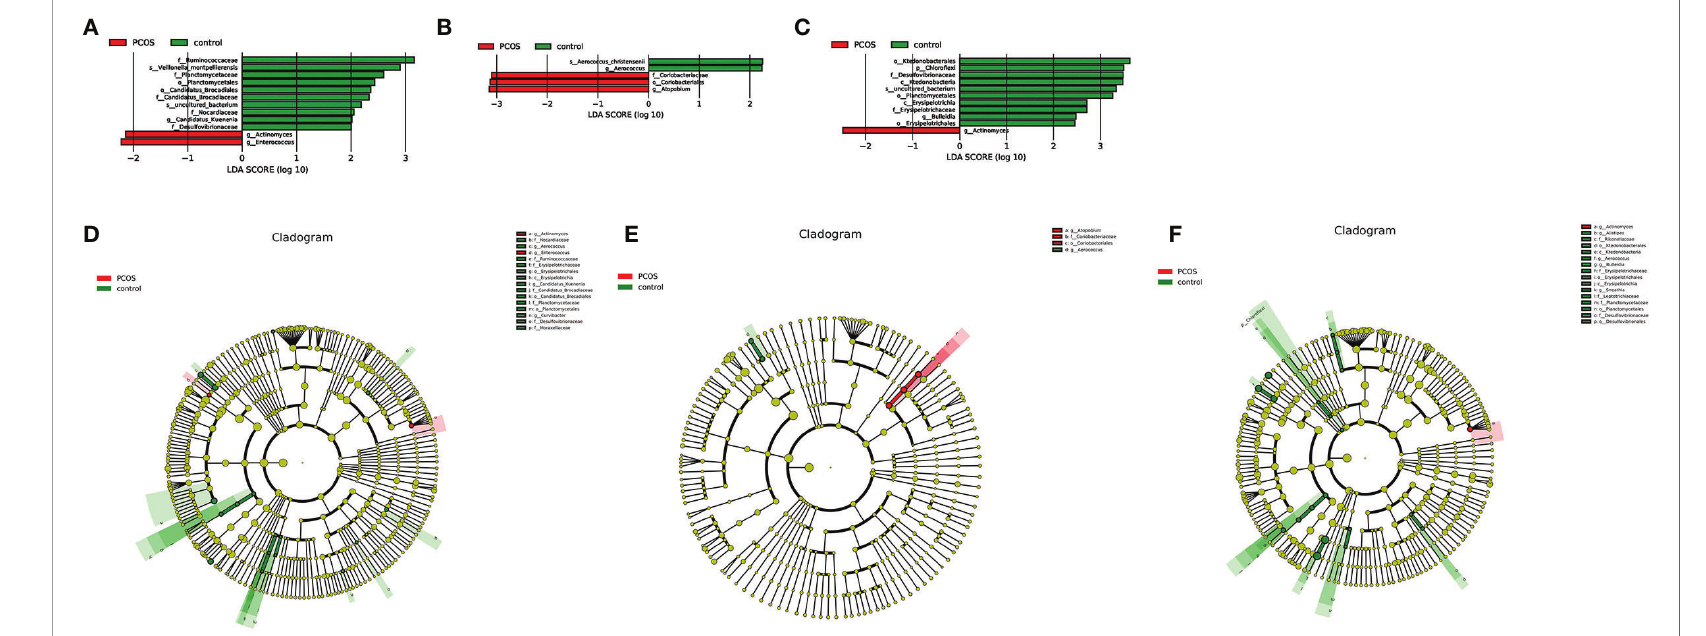
FIGURE 5 | Linear discriminant analysis (LDA) score histogram and cladogram of the total polycystic ovary syndrome (PCOS) and total control groups, the L-PCOS and L-control groups, and the N-PCOS and N- control groups. (A) LDA score histogram of the total PCOS and total control groups; (B) LDA score histogram of the L-PCOS and L-control groups; (C) LDA score histogram of the N-PCOS and N-control groups; (D) LDA score cladogram of the total PCOS and total control groups; (E) LDA score cladogram of the L-PCOS and L-control groups; (F) LDA score cladogram of the N-PCOS and N-control